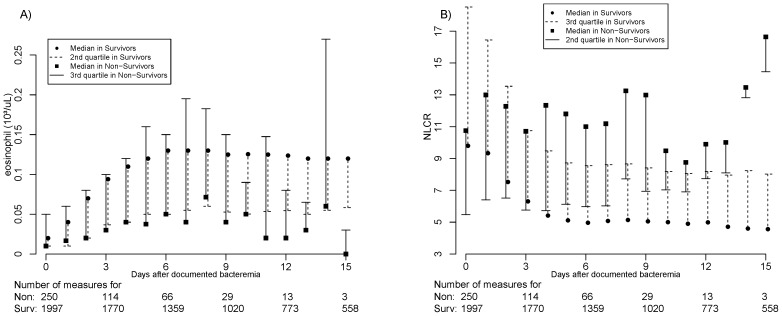
Median for eosinophil count and NLCR for survivors and non-survivors in each day.Legend: 2A) The median eosinophil count for each day in survivors (circle) and non-survivors (square) in the first 15 days. The dashed line represents the second quartile of the eosinophil count on specific days in survivors. The continuous line represents the third quartile of the eosinophil count on specific days in non-survivors. The blood tests for each day and for survivors (Surv) and non-survivors (Non) are shown at the bottom of the figure. 2B) The median of the NLCR count for specific days in survivors (circle) and non-survivors (square) in the first 15 days. The dashed line represents the third quartile of the NLCR count on specific days in survivors. The continuous line represents the second quartile of the NLCR count for specific days in non-survivors. The blood tests for each day and for survivors (Surv) and non-survivors (Non) are shown at the bottom of the figure.